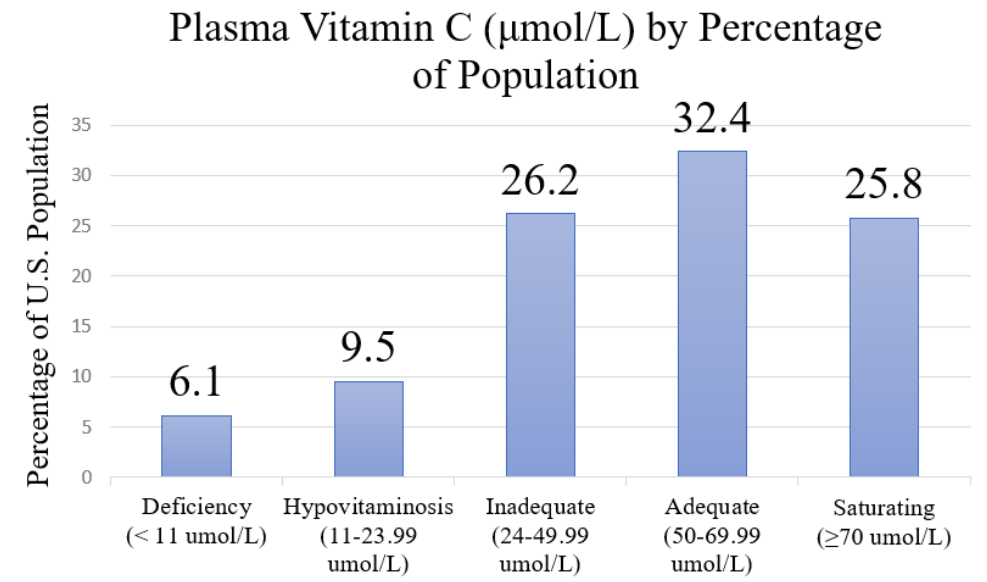
Figure 2. Prevalence of Plasma Vitamin C Levels in the USA Population in 2003–2006.